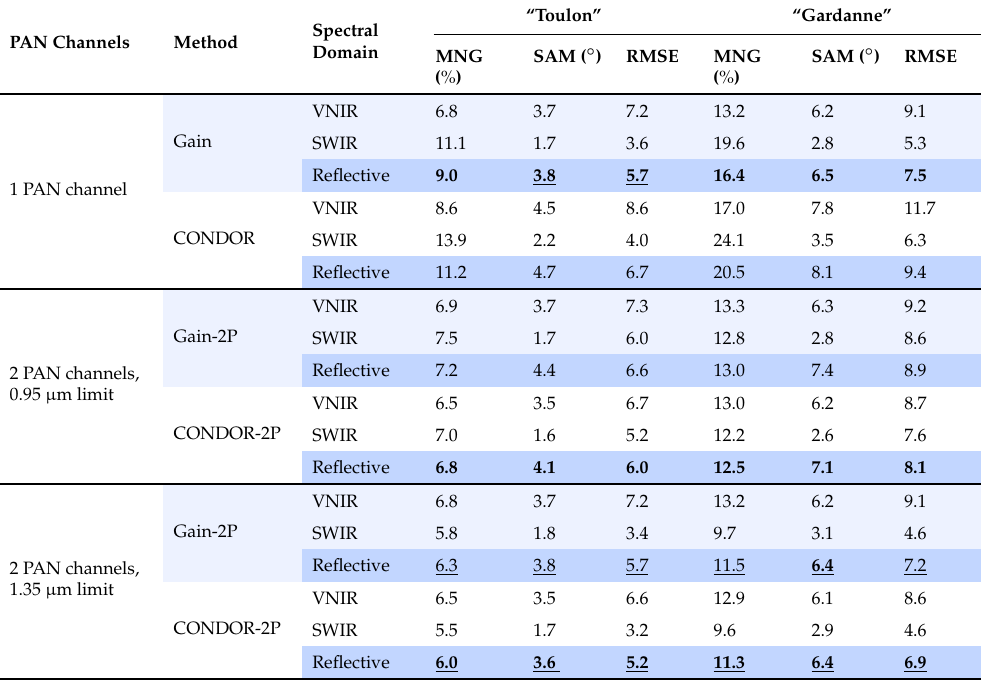
Table 2. “Toulon” and “Gardanne” datasets: quality criteria calculated on the whole images. The optimal values in the reflective domain are in bold (by comparing the methods) and underlined (by comparing the PAN configurations).